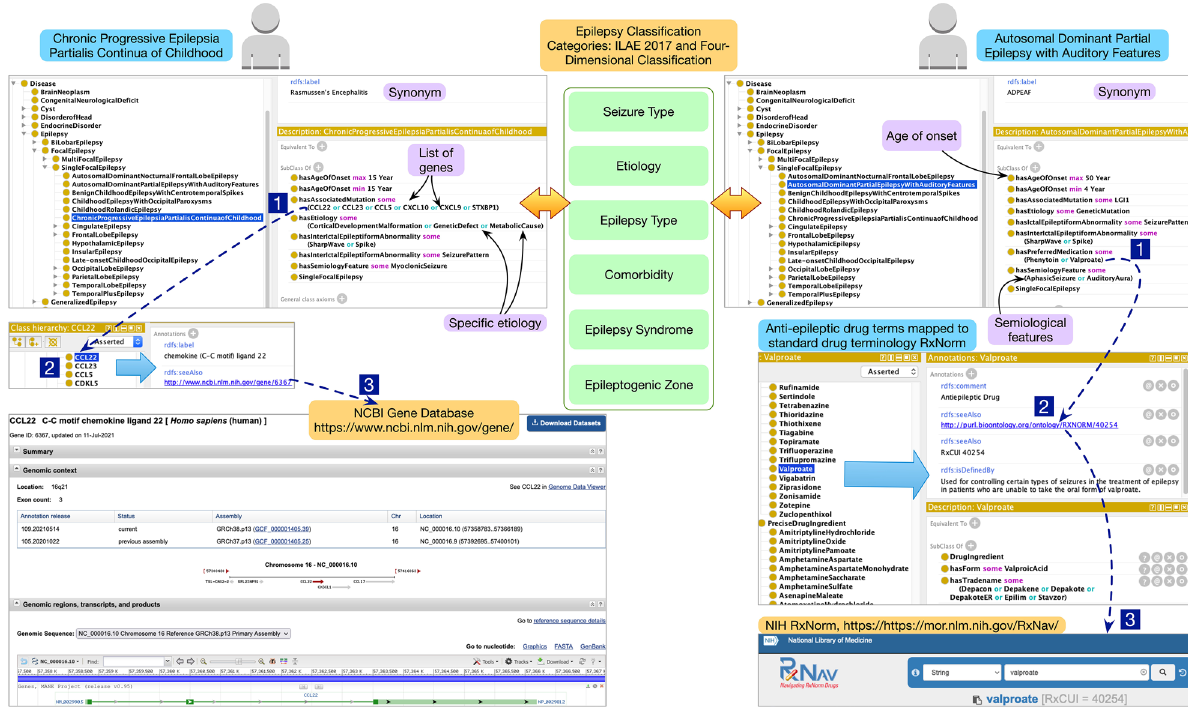
Figure 6. Modeling of two epilepsy syndromes in EpSO that includes attributes based on both ILAE 2017 classification system and the four-dimensional classification